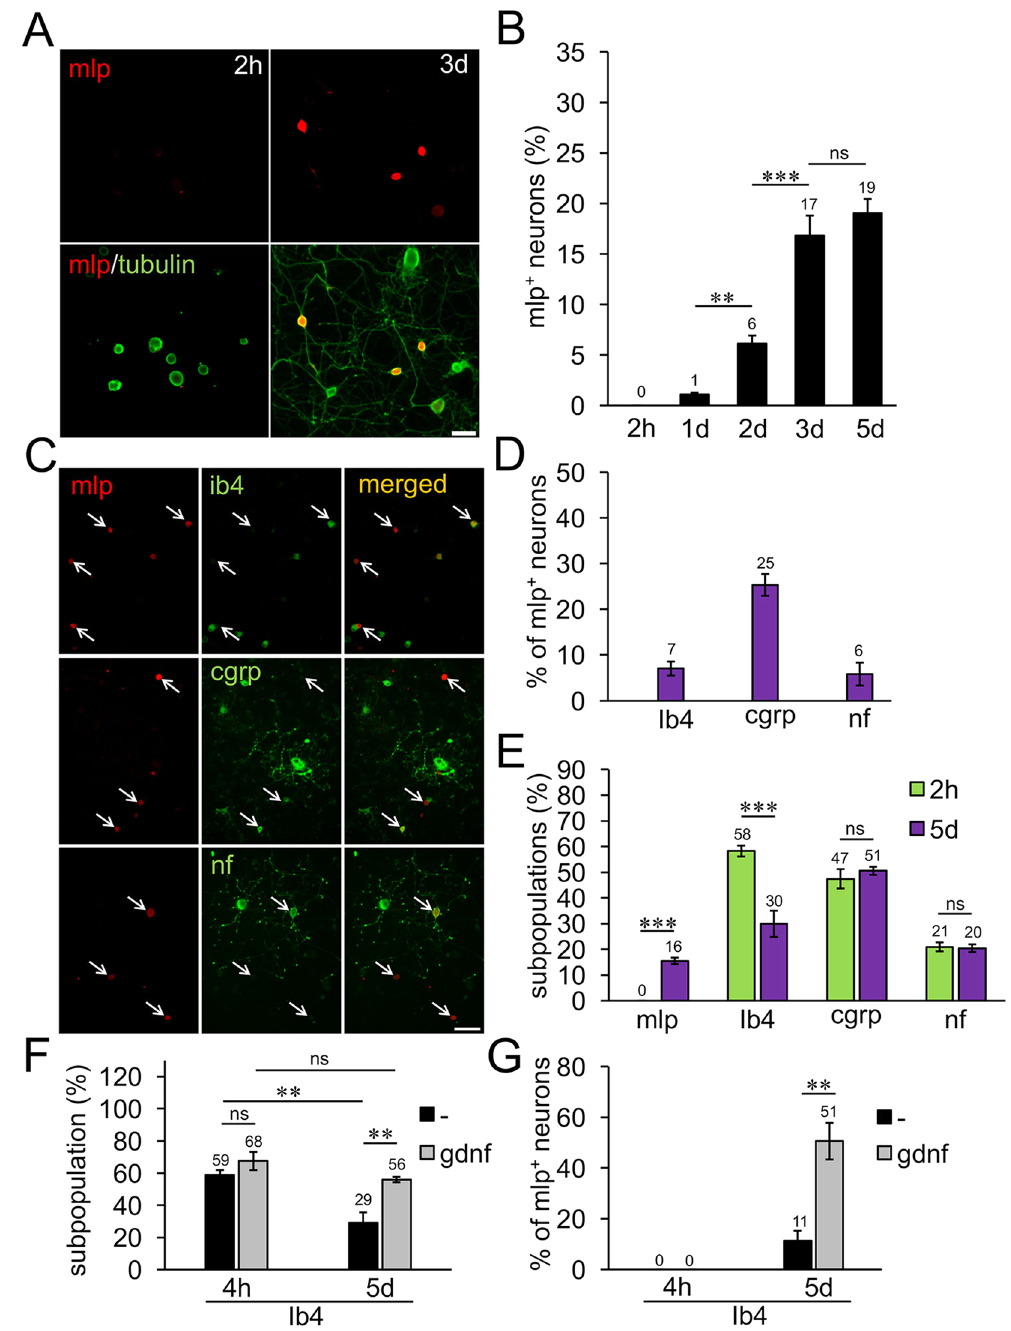
Figure 4. Induction of MLP expression in nociceptive DRG neurons in culture. ( A ) Cultures of dissociated adult rat DRG neurons were stained for MLP (red) and β III-tubulin (green) 2 hours (2 h) and 3 days (3 d) after cell preparation. Scale bar: 50 µ m. ( B ) Quantification of MLP-positive (mlp + ) DRG neurons in cultures as in ( A ) at 2 h and 1–5 days after plating. Data represent mean percentages ± SEM of 2 independent experiments each with 3–4 repeat wells. ( C ) Representative pictures of cultures co-stained for MLP (red, arrows) and either calcitonin gene-related peptide (cgrp), isolectin B4 (ib4) and 200 kDa neurofilament (nf) (green) after several days in culture. Scale bar: 100 µ m. ( D ) Percentage of neurons double-positive for MLP and either ib4, cgrp or nf in DRG cultures as described in ( C ) at 5 d after plating. ( E ) Quantification of mlp-, ib4-, cgrp- and nf-subpopulations in relation to all β III-tubulin-positive neurons as described in ( C ) at 2 h and 5 d. ( F ) Quantification of IB4-positive neurons cultured either with or without glial-derived neurotrophic factor (gdnf) for 4 h and 5 d after plating. ( G ) Quantification of MLP-positive neurons co-stained with IB4 in cultures as described in ( F ). Treatment effects: ** p < 0.01, *** p < 0.001, ns: